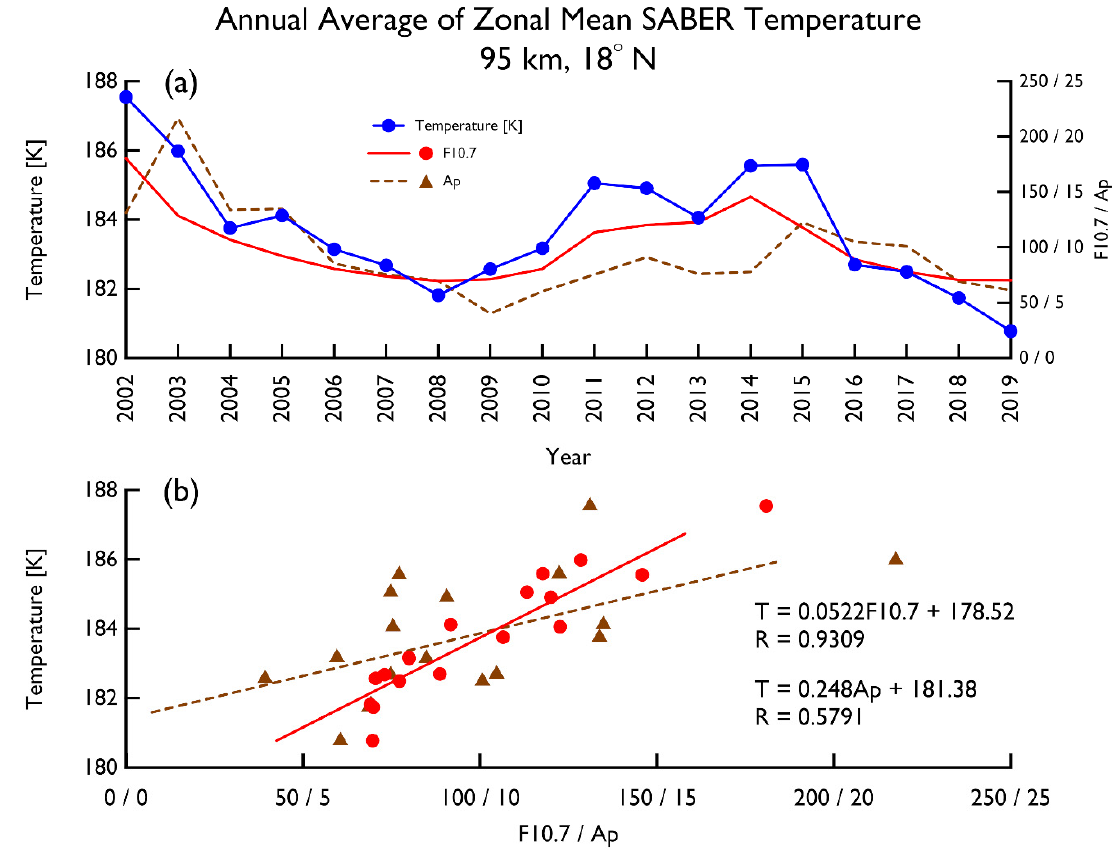
Figure 5. Zonal mean annual average of SABER temperature at 18° N at 95 km. ( a ) Time series of temperature (blue line with dots), F10.7 (red line), and Ap index (brown dashed line). ( b ) Trend analysis of temperature as a function of the F10.7 (red line and dots) and of the Ap index (brown dashed line and triangles).